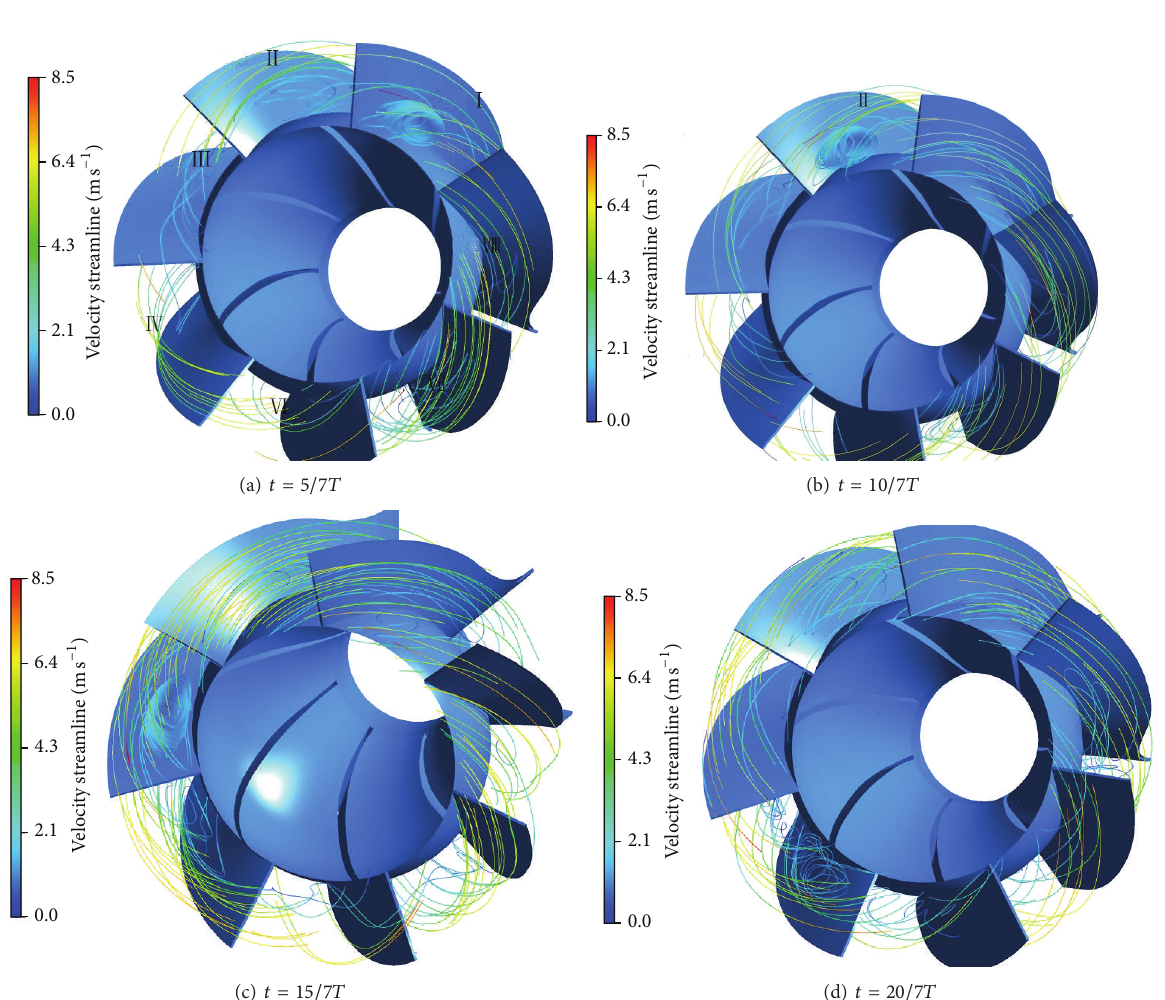
Figure 20: Period of stall propagation at 0.65 𝑄